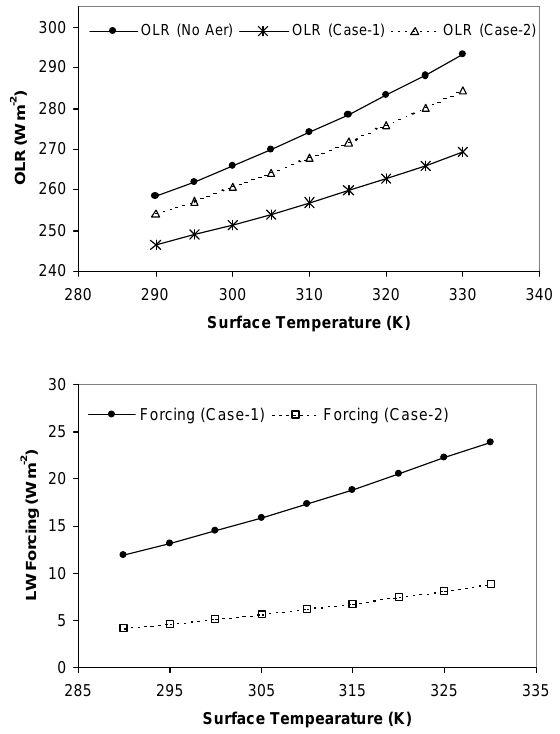
Fig. 19. (a) Effect of surface temperature on OLR (b) Effect of sur- 19(a) Effect of surface temperature on OLR (b) Effect of surface temperature on long face temperature on long wave radiative forcing. Here, case-1 and wave radiative forcing. Here, case-1 and case-2 correspond to aerosol optical depths 1.0 case-2 correspond to aerosol optical depths 1.0 and 0.33, respec- and 0.33 respectively. Desert aerosol model of Hess et al. (1998) was used. tively. Desert aerosol model of Hess et al. (1998) was